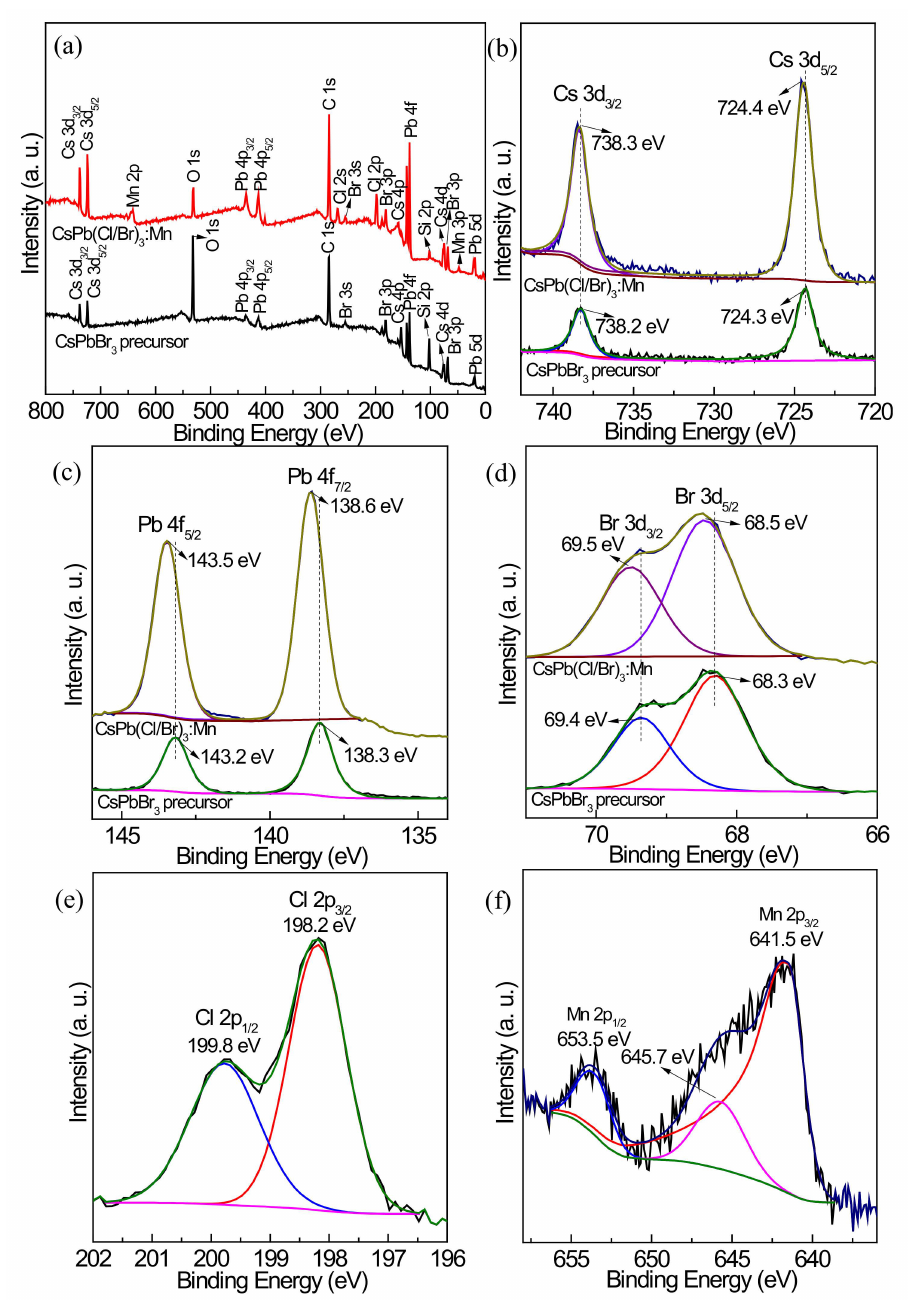
Figure 10. ( a ) Survey scan XPS spectra of the CsPbBr 3 precursor and the optimum CsPb(Cl/Br) 3 :Mn product and their high-resolution XPS spectra of ( b ) Cs 3d, ( c ) Pb 4f, and ( d ) Br 3d. High-resolution XPS spectra of the optimum CsPb(Cl/Br) 3 :Mn product: ( e ) Cl 2p and ( f ) Mn